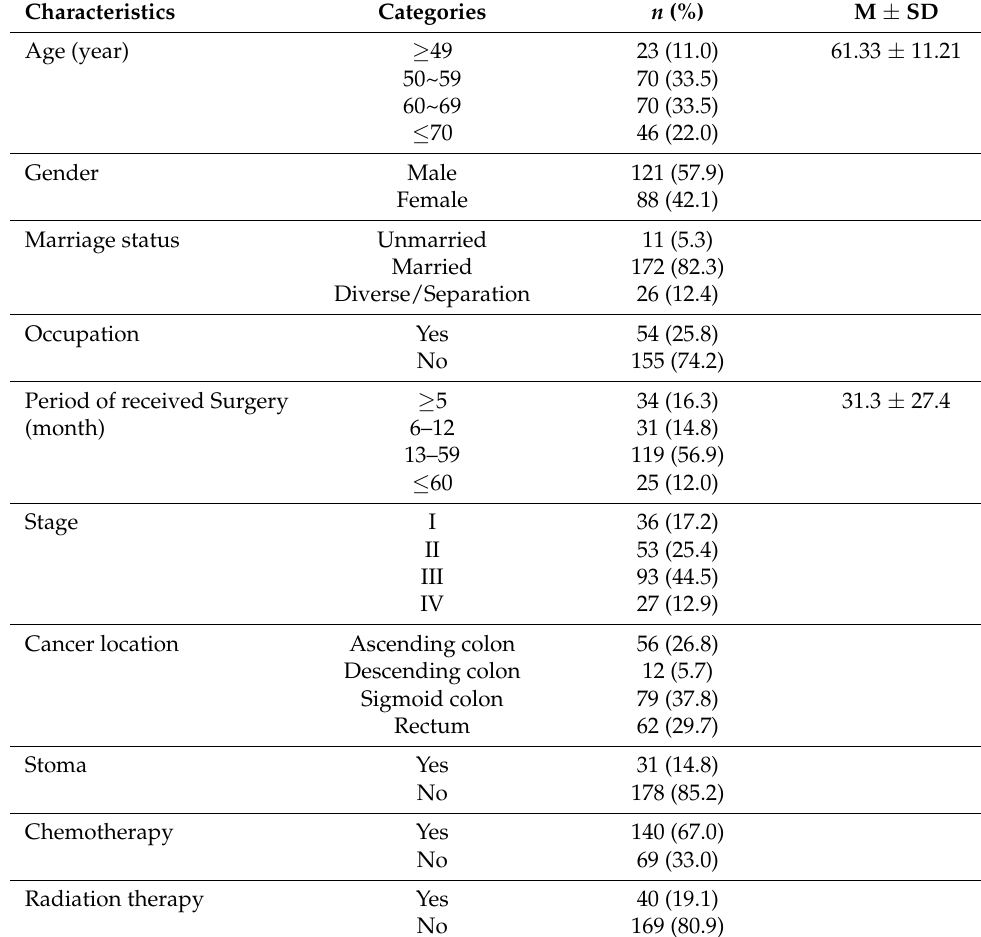
Table 1. Characteristics of Subjects and Research Concept Variables.